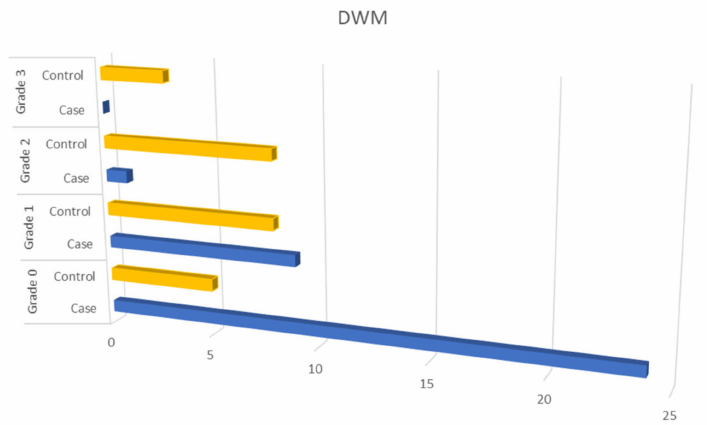
Figure 2. Comparison of patients with OSAHS and controls group with respect to SVD in the